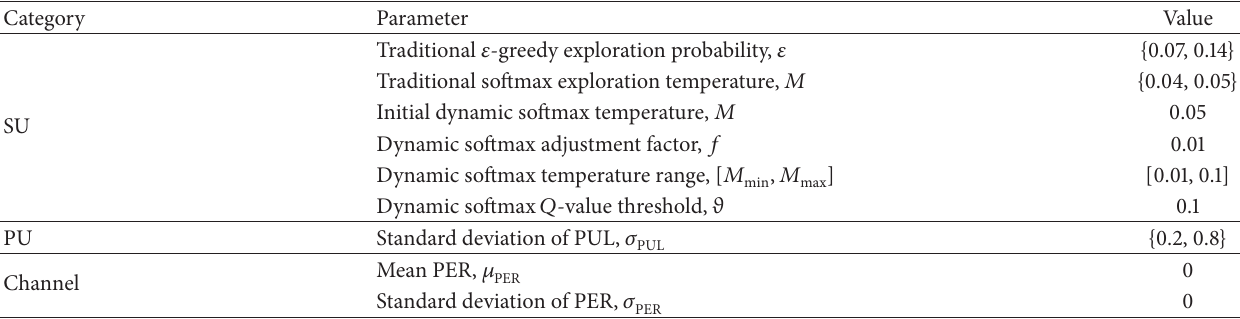
Algorithm 1: Dynamic softmax algorithm at SU node 𝑖 . Table 5: Simulation parameters and values for investigating the exploration